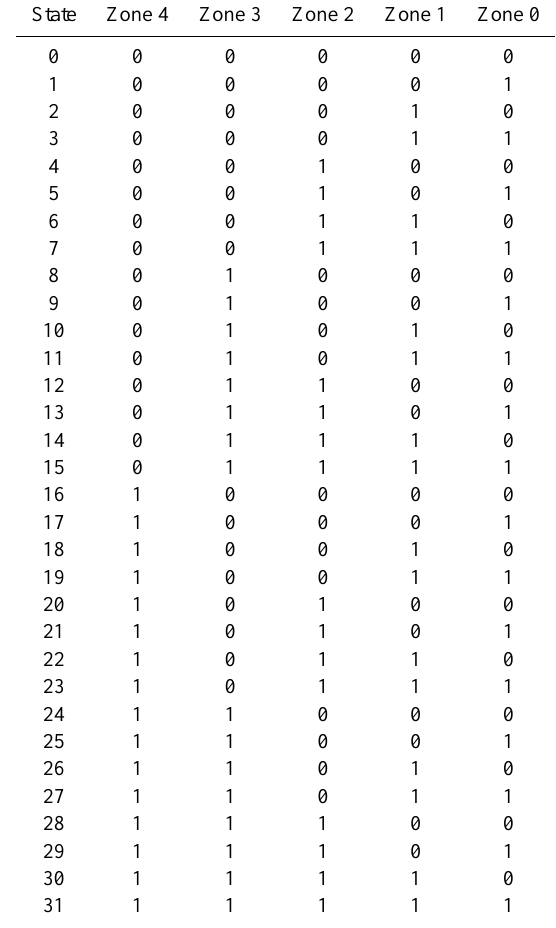
Table 2. Zone and state definition used in the construction of a di- rected graph of a Markov chain. “0” and “1” refer to the no oc- currence or occurrence of an earthquake for a given zone. For five zones, there are 32